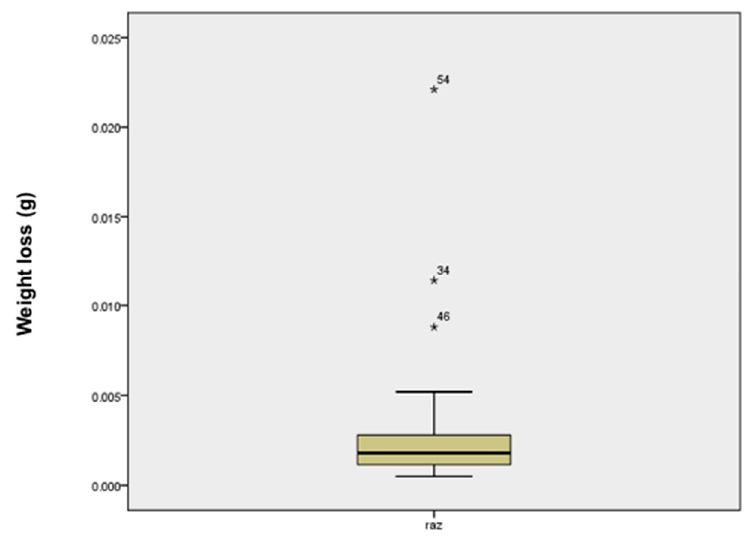
Figure 1. Distribution of mass differences in grams before and after brushing for all the samples. Three samples stood out and were excluded form statistical analysis.